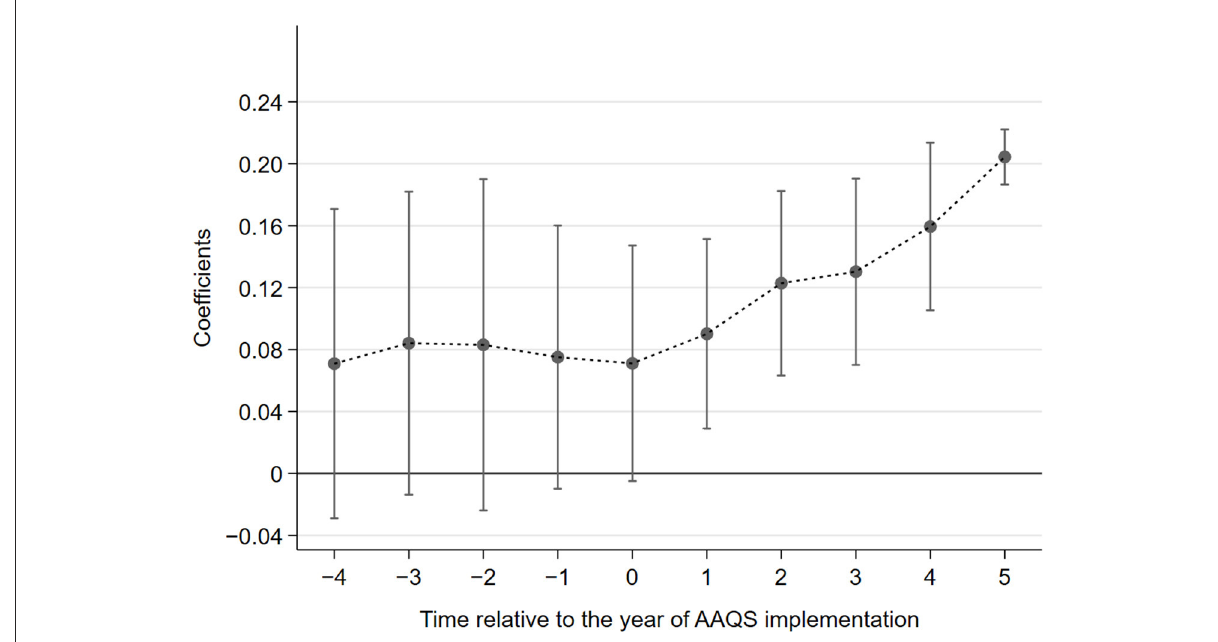
FIGURE4 Parallel trend test.